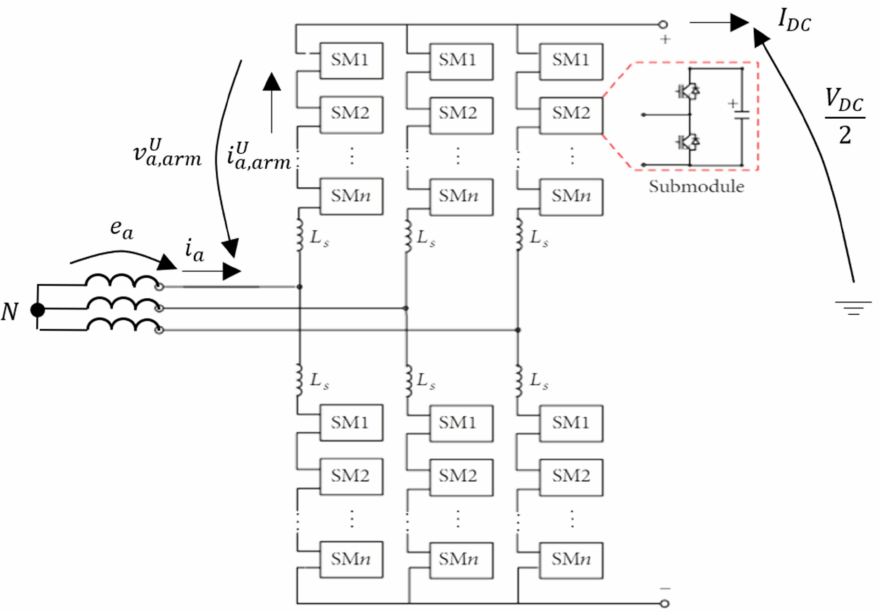
Figure 5. Modular multilevel